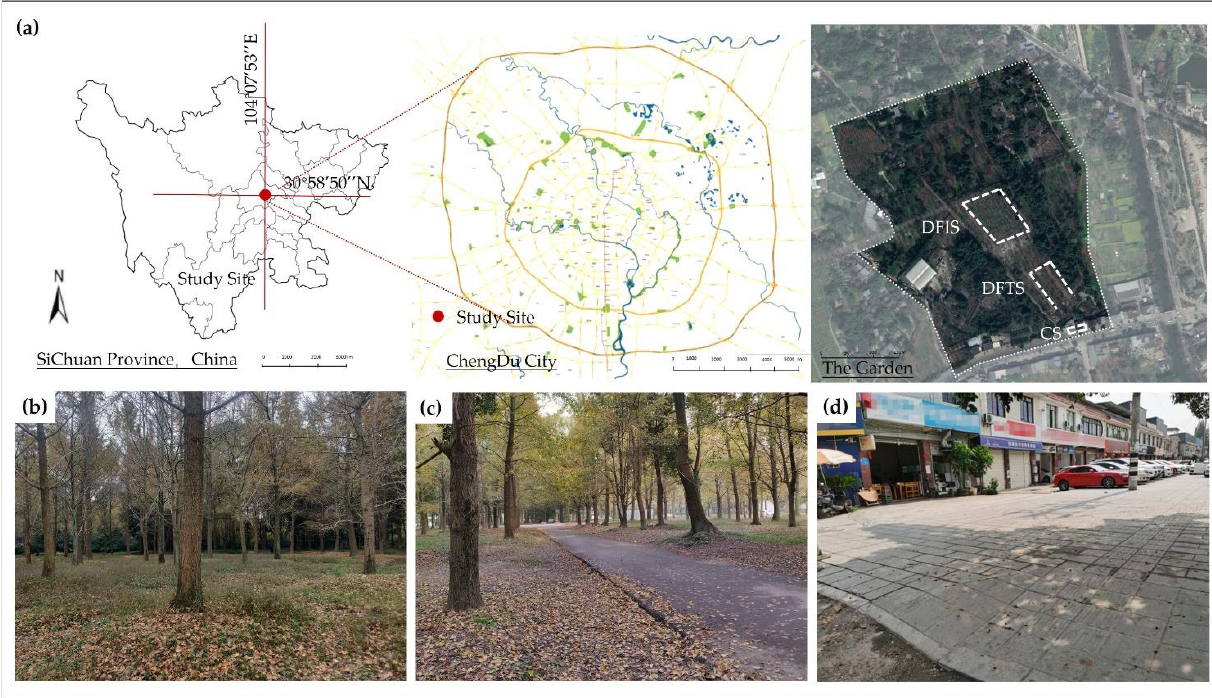
Figure 1. Study location and three stimulating environments: ( a ) map of the experimental site and study site; ( b ) DFIS: deciduous forest interior setting; ( c ) DFTS: deciduous forest trail setting; ( d ) CS: city setting.